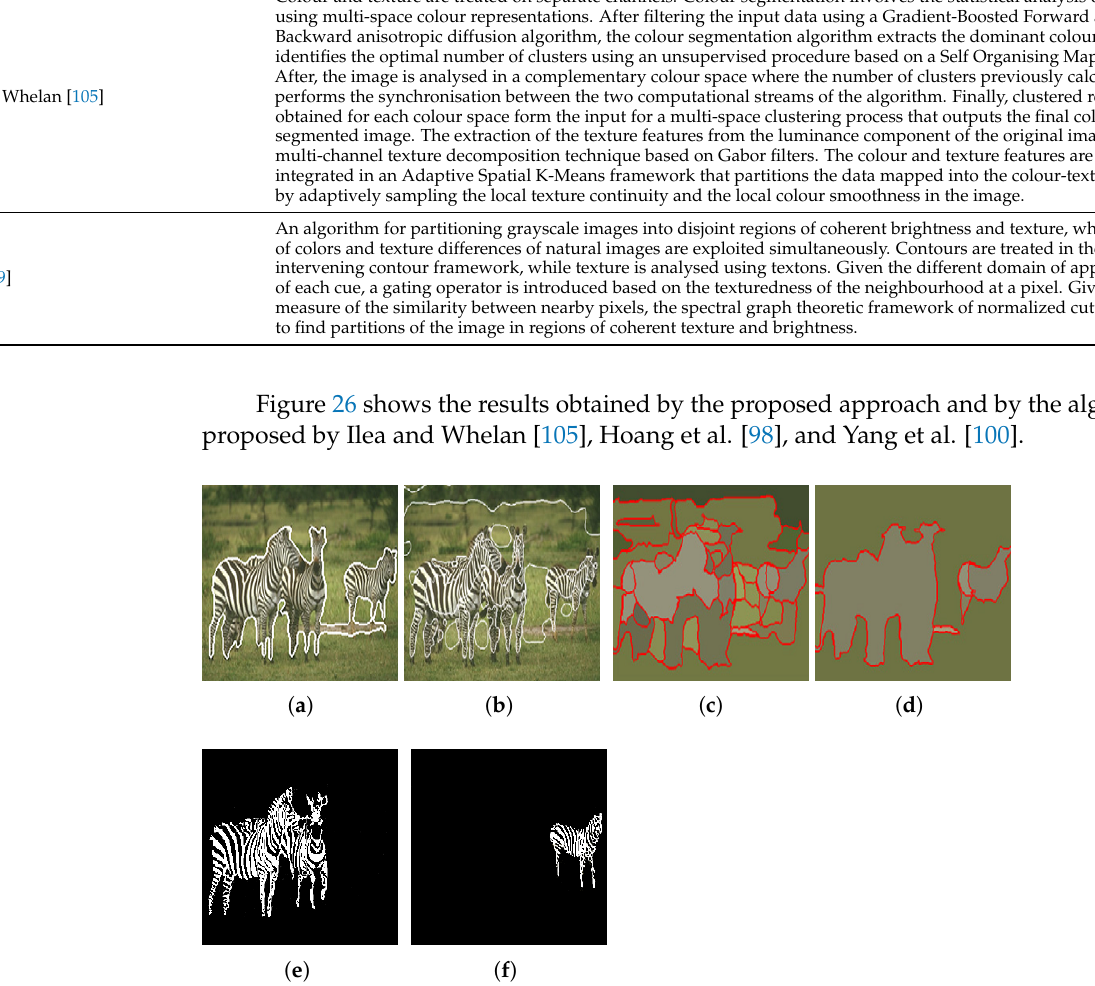
Figure 26. Results obtained using ( a ) Ilea and Whelan [105] algorithm; ( b ) Hoang et al. [98] algo- rithm [105]; ( c ) Yang et al. [100] algorithm when γ = 0.1; ( d ) Yang et al. [100] algorithm when γ = 0.2; ( e , f ) the proposed approach. Images ( a – d ) referenced from Ilea and Whelan